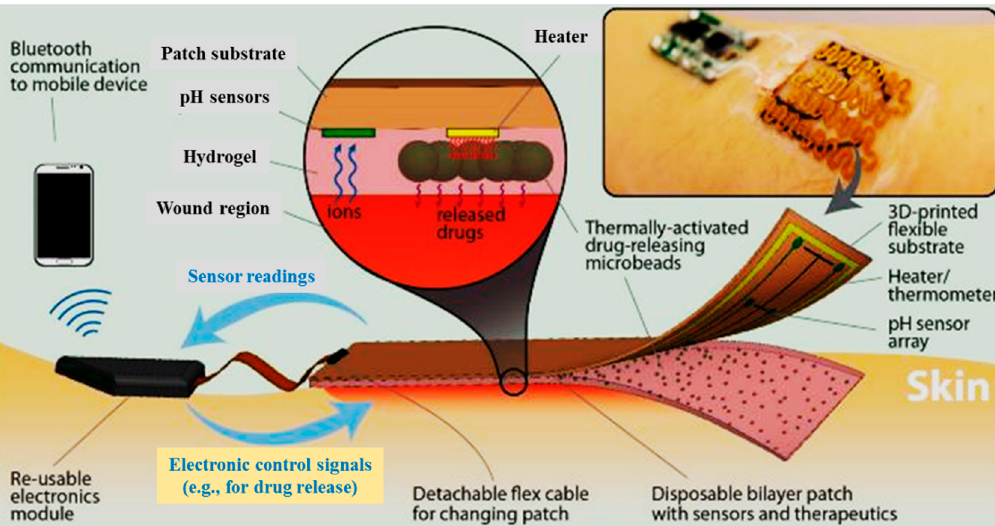
Figure 8. Schematic of a flexible “smart” wound dressing. The dressing is comprised of a pH sensor and a flexible heater to trigger thermo-responsive carriers containing drugs. Drug carriers are embedded in a sheet of alginate hydrogel, casted around the pH sensors and on the heater. Finally, the sensors and the heater are connected to an electronic module that is able to record the data from sensors and power the heater. The electronic module can also communicate with computers and smartphones wirelessly [120] .